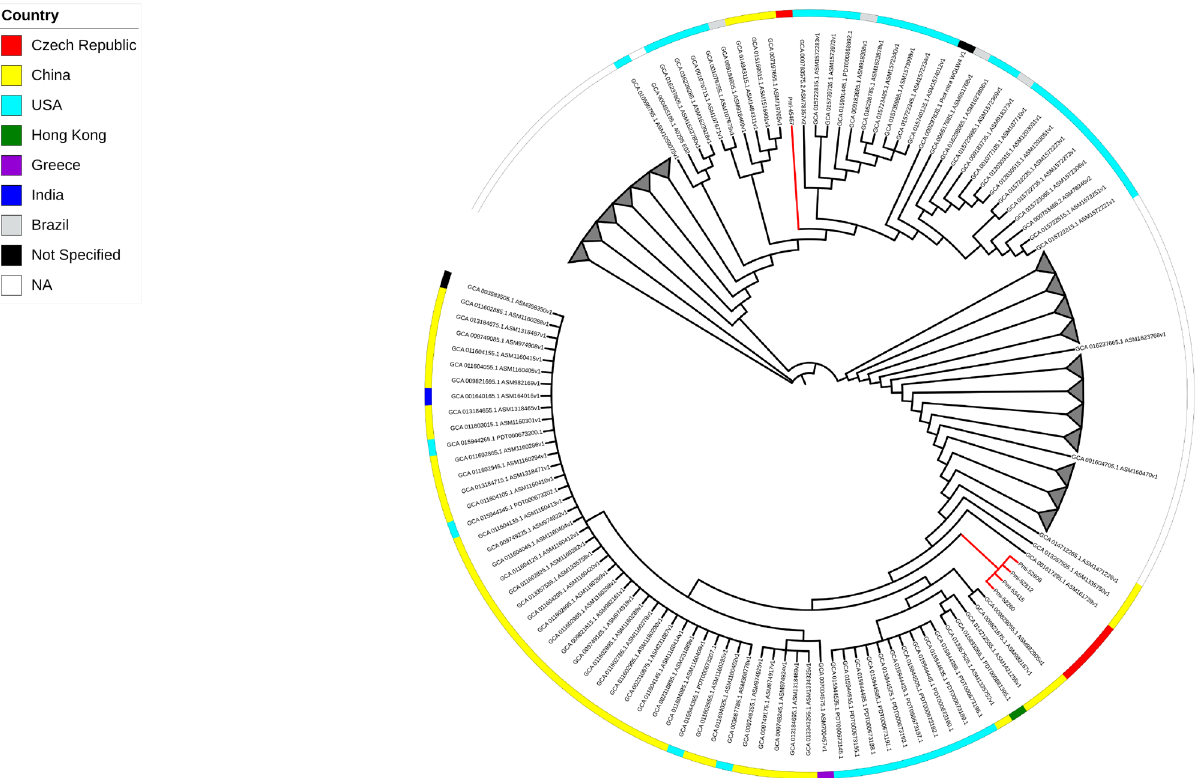
Figure 4. SNPs-based phylogeny of the five P. mirabilis isolates with 582 genomes downloaded from NCBI database. Red nodes indicate the Isolates from the study. Grey triangles indicate collapsed